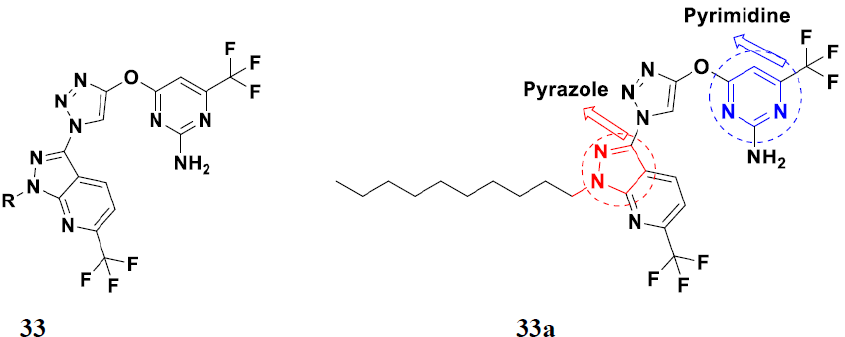
Figure 36. Structure of pyrimidine ‐ pyrazole based hybrids and the most promising compound 33a.